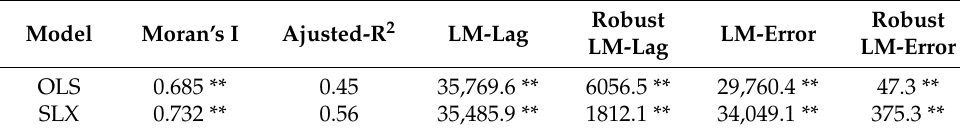
Table 2. Moran’s I and LM test of OLS and SLX model regression residuals. Model Moran’s